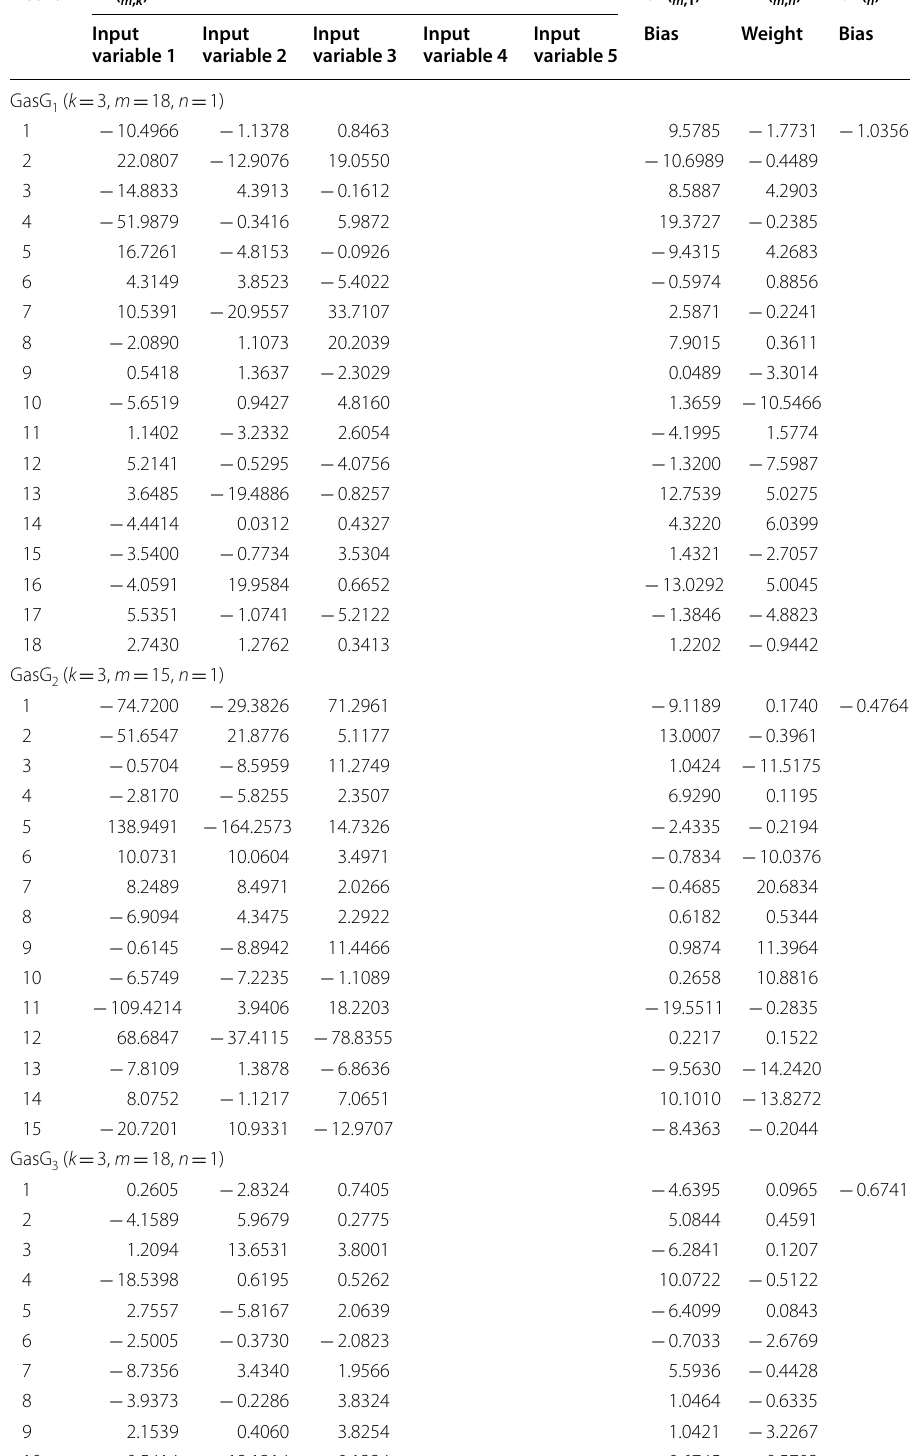
Table 7 Weighting and bias coefficients of the best ANN models (new gas geothermometers: GasG to GasG 1 8